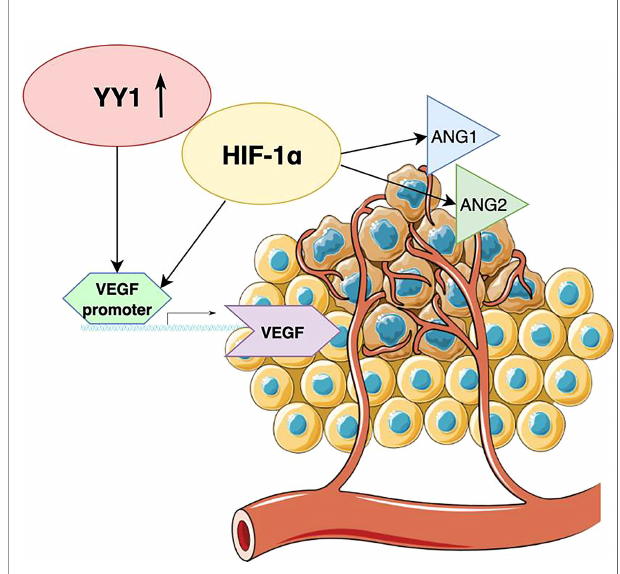
FIGURE 3 | Schematicdiagram illustrating the roleof YY1 in tumor angiogenesis. YY1 regulates the increase ofVEGF bysuppressing HIF-1 a , which also upregulates the expression of angiopoietinfactors ANG-1 and